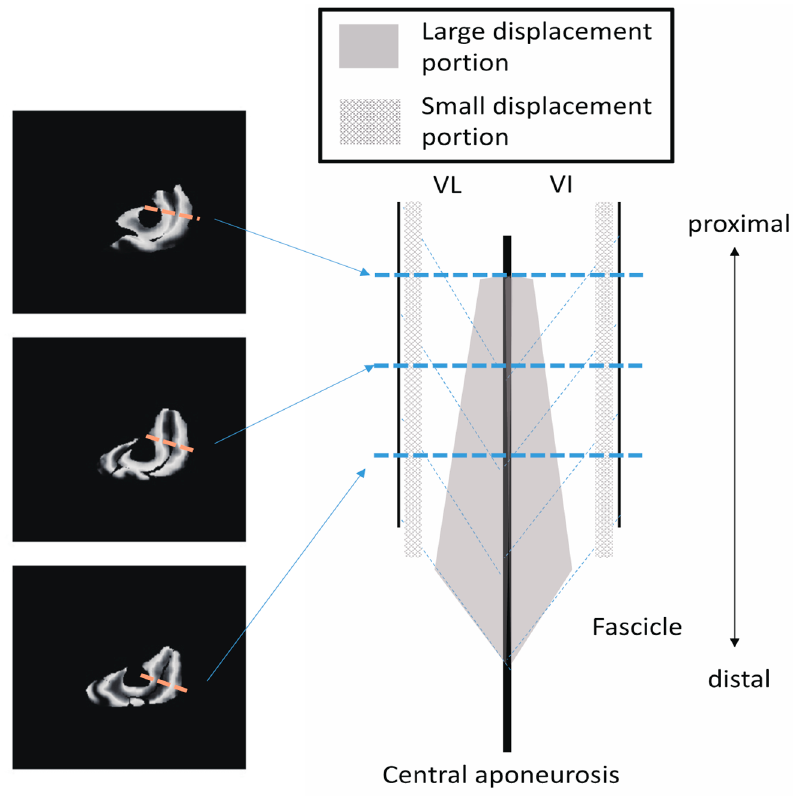
Figure 10. A schematic diagram on the sagittal cutting plane of the VI and VL portraying the differences in Z -axis displacement both in-plane and along the proximal–distal direction shown in Figure